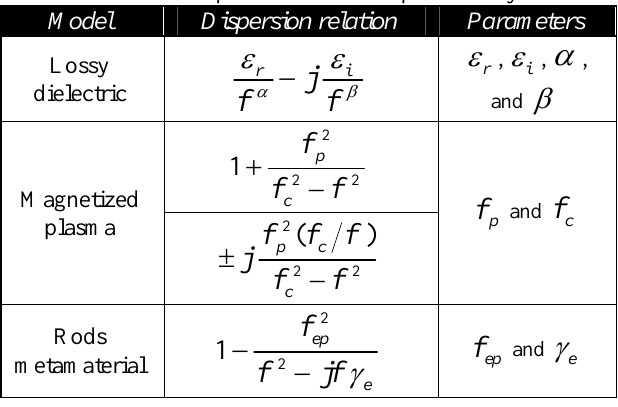
Table 2: Dispersion models of permeability Model